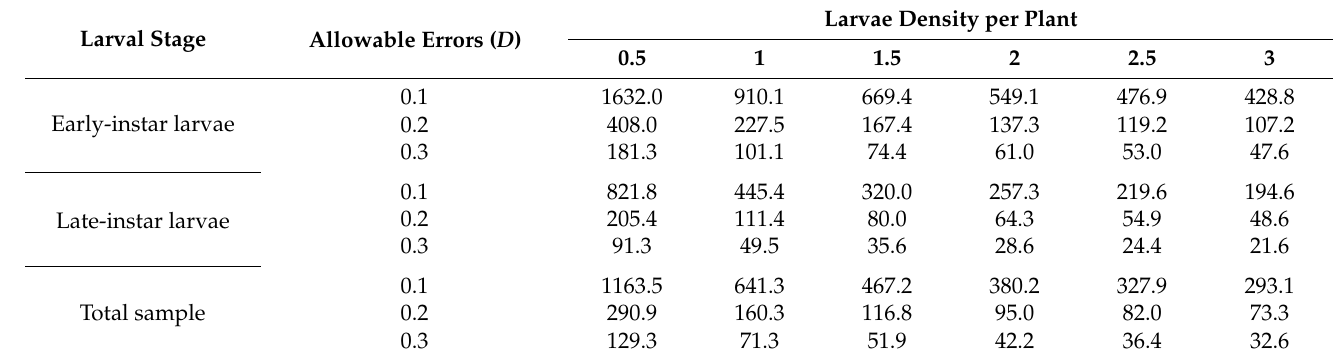
Table 4. Theoretical sampling number of S. frugiperda under different densities of larvae in maize fields in